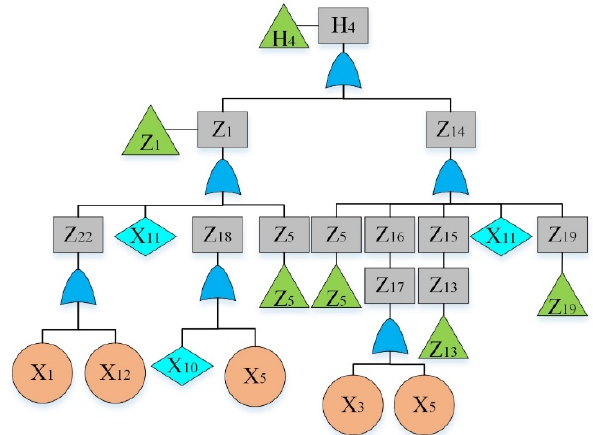
Figure 5. Fault tree of a hydraulic system: sub-tree III.